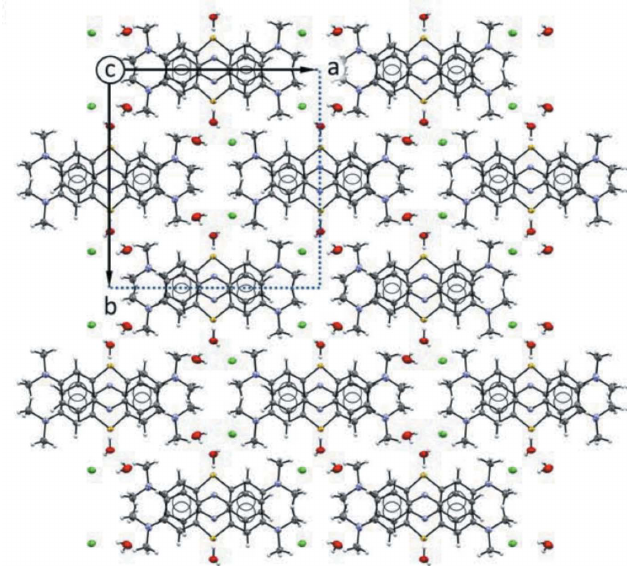
Figure 4 The crystal packing of compound ( II ) viewed along the a axis, with the unit cell highlighted in the upper left-hand corner. Displacement ellipsoids are drawn at the 50% probability level.